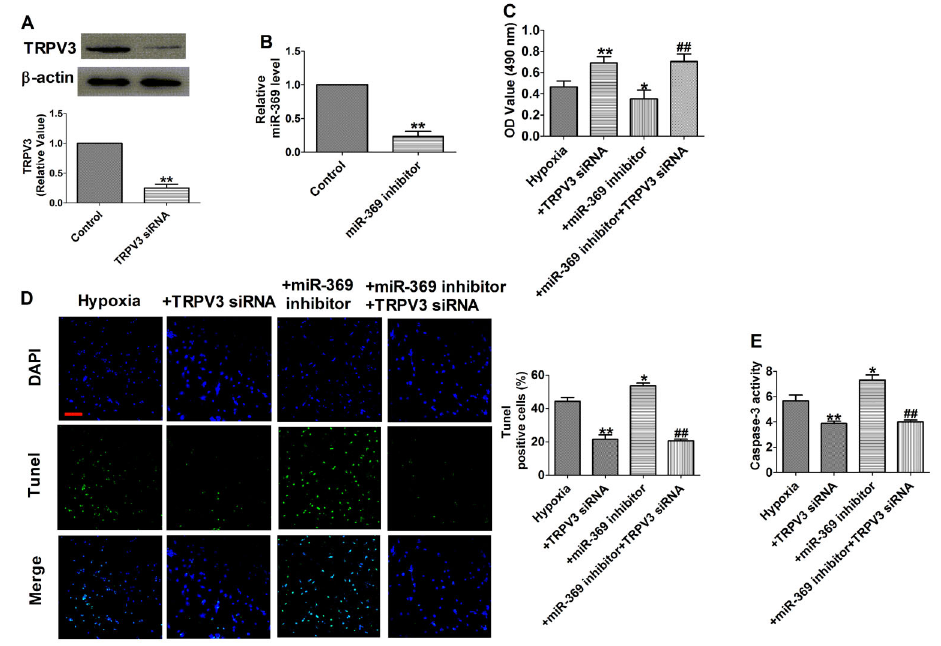
Figure 5. A , Expressions of TRPV3 protein (n=3). B , Relative mRNA level of miR-369 (n=6). C, MTT assay (n=6). D , Representative images of TUNEL staining of cardiomyocytes showing the apoptotic cells (100 (cid:2) ; scale bar, 100 m m) and statistical results of TUNEL-